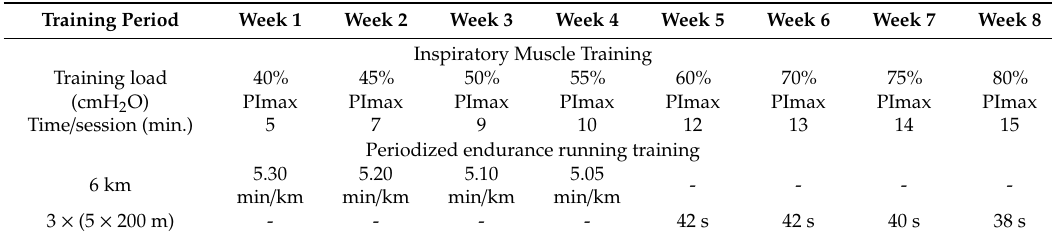
Table 1. Specification of the load application during eight weeks of inspiratory muscle training (IMT) and incremental running endurance (IRE)